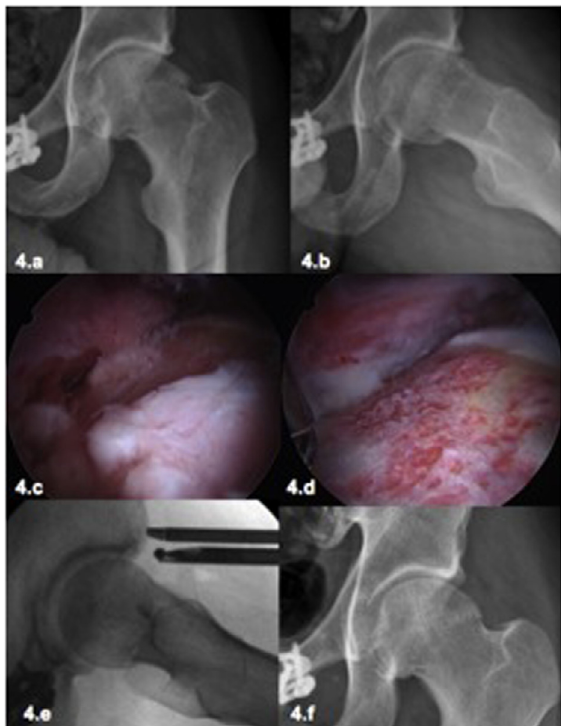
Figure 4. Male patient, 32-year old physician, intensive recrea- tional sports (Karate), 4 years after left hip arthroscopy for FAI with persistent pain and restriction of movement (ROM). Despite the evident radiological signs of osteoarthritis (4a, 4b) the patient insisted on a repeat arthroscopy due to the pain and limitations for sports. Considering the young age and the conserved joint space in the load-bearing area, a revision arthroscopy was performed. During the hip arthroscopy the chondrolabral damage was treated in the central compartment. In the peripheral compartment the osteophytes were identified and resected (4c) as well as the cam deformity. A satisfactory correction of the deformity was achieved (4d–4f).